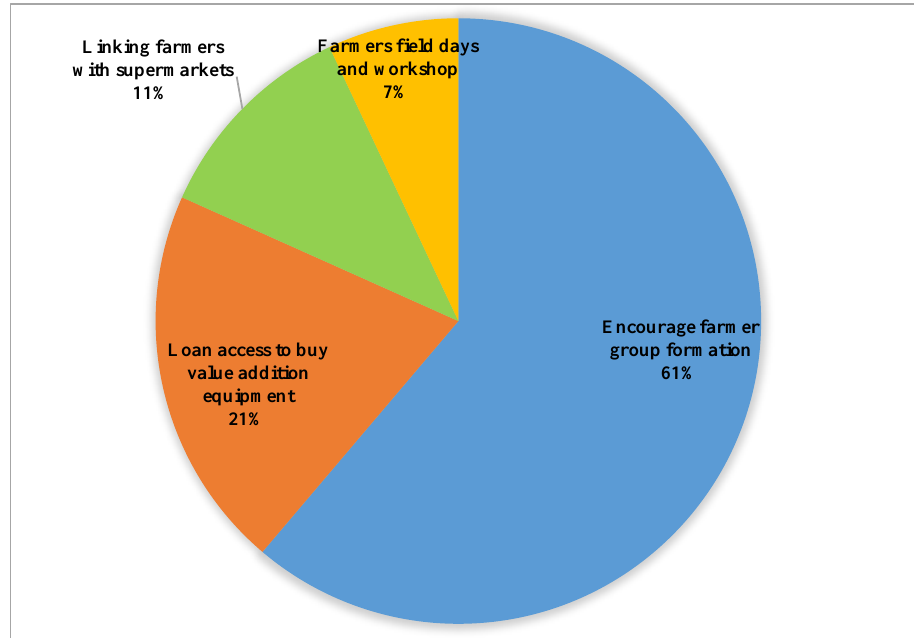
Figure 8. Suggested strategies to promote effective Irish potato value addition X 2 =70.547; df=3;